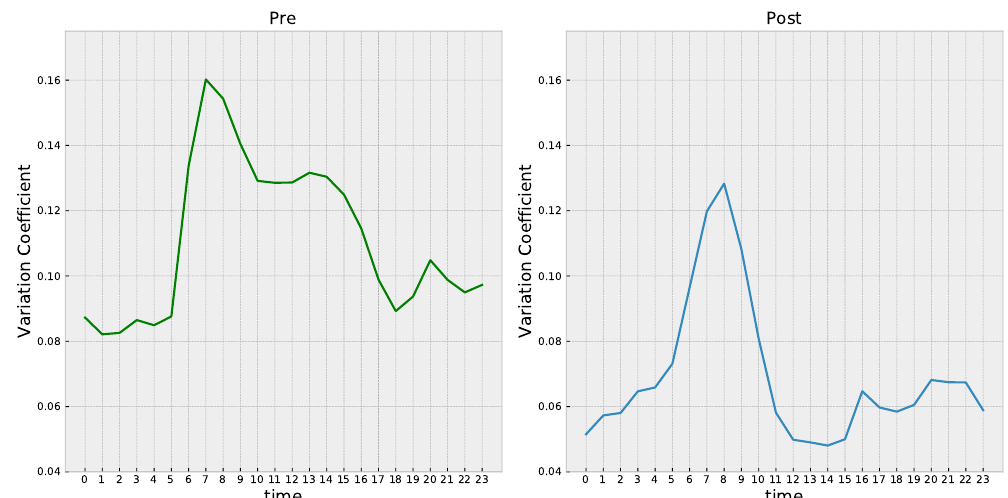
Figure 6. Comparison of variation coefficient to visualise the changes in system demand. The magnitude of the variation coefficient decreases in the post-case, the morning peak is delayed by an hour and the variation in the evening peak is less pronounced. The plot on the left represents w/c 02/03/20 and the one on the right represents w/c